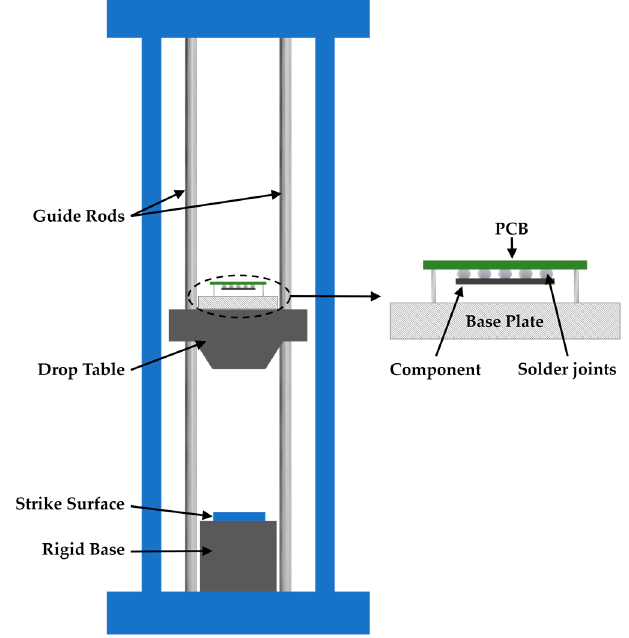
Figure 4. Schematic configuration of the drop test apparatus.